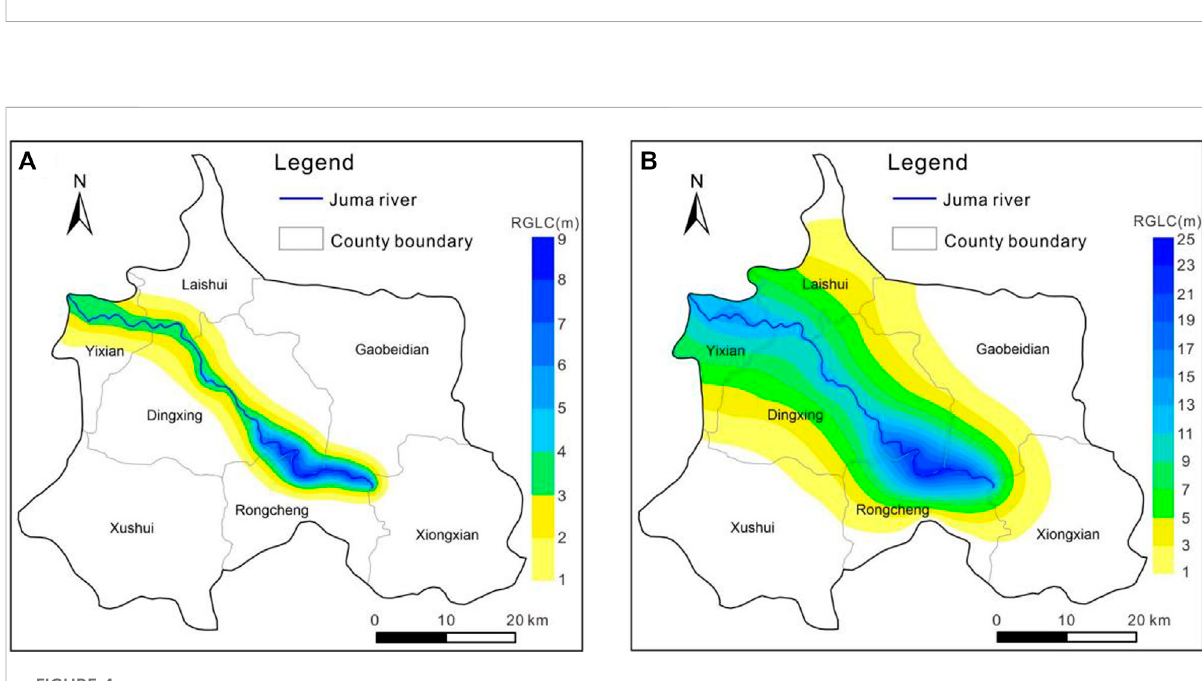
FIGURE 3 Comparison of the fl ow fi elds with and without river replenishment: (A) at the end of 2020 and (B) at the end of 2035.